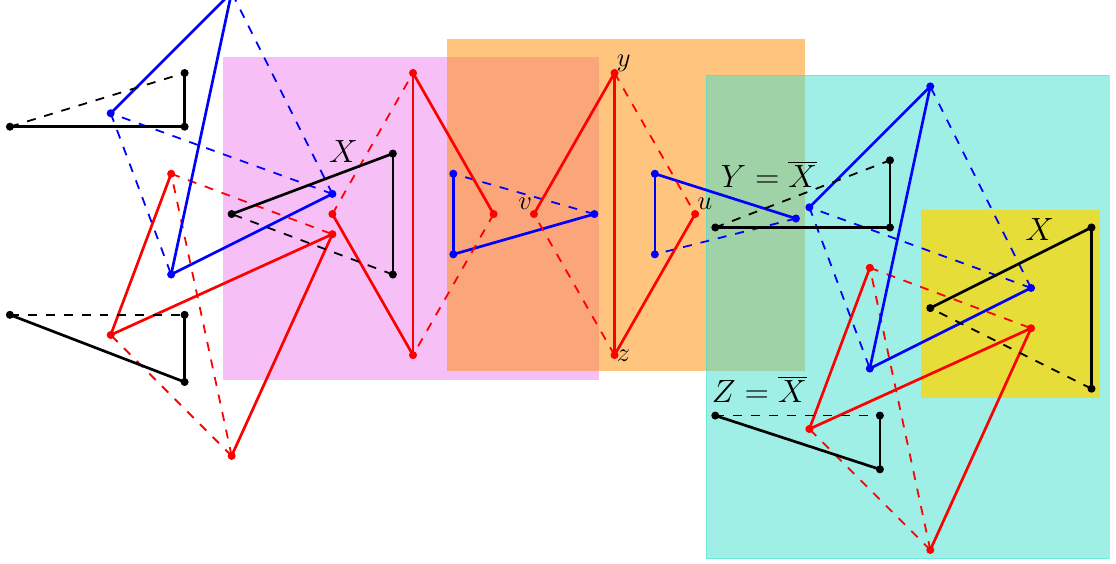
Figure 2. A drawing produced by the reduction in [15]. The yellow region contains a variable gadget, the blue region contains a splitting gadget, the orange region contains a wire gadget, and the violet region contains an inverter